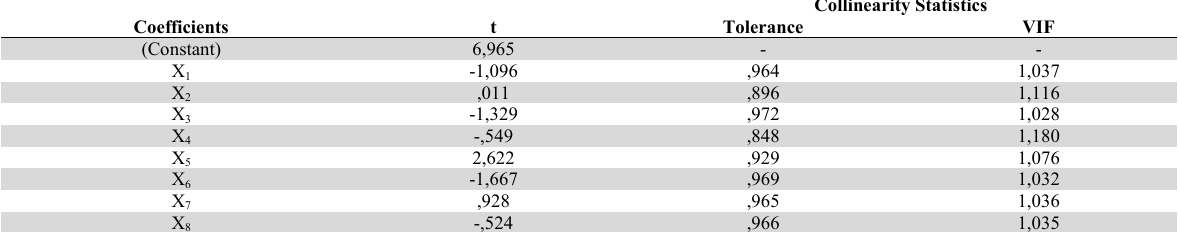
Multicollinearity test